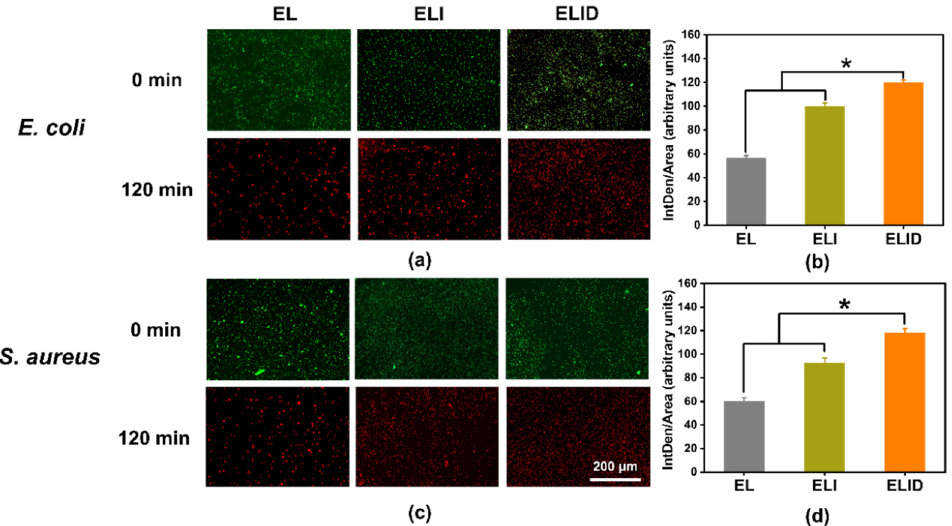
Figure 4. ( a , c ) Fluorescence images of LIVE/DEAD-stain biofilms after EL, ELI, and ELID treatment for 120 min; ( b , d ) analysis of red fluorescence intensity after EL, ELI, and ELID treatment for 120 min ( n = 3, * means p ≤ 0.05).